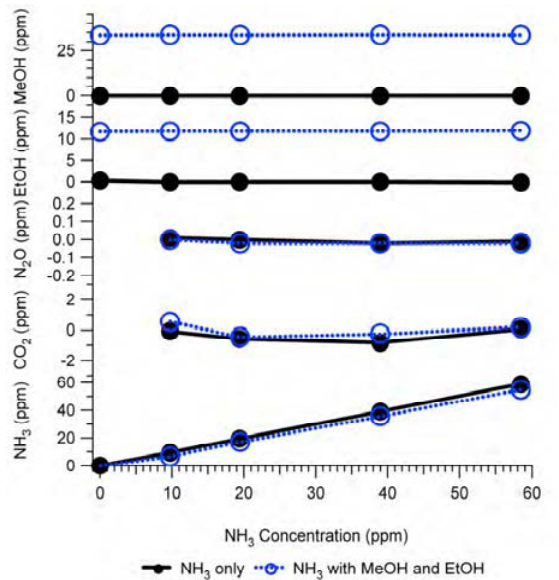
Figure 7. Interference of NH in Example #2 as a target gas. Black solid lines with closed 3 only (NH = variable and other gases = 0 ppm) circles are experimental responses to NH 3 3 and blue dash lines with open circles are experimental responses to NH in the presence of 3 MeOH (35.2 ppm) and EtOH (12.2 ppm). All gas mixtures were in N balance and not 2 as a target gas were not available humidified. Analytical results of the interference of NH 3 because the IRSA method is used to estimate the interference of non-target